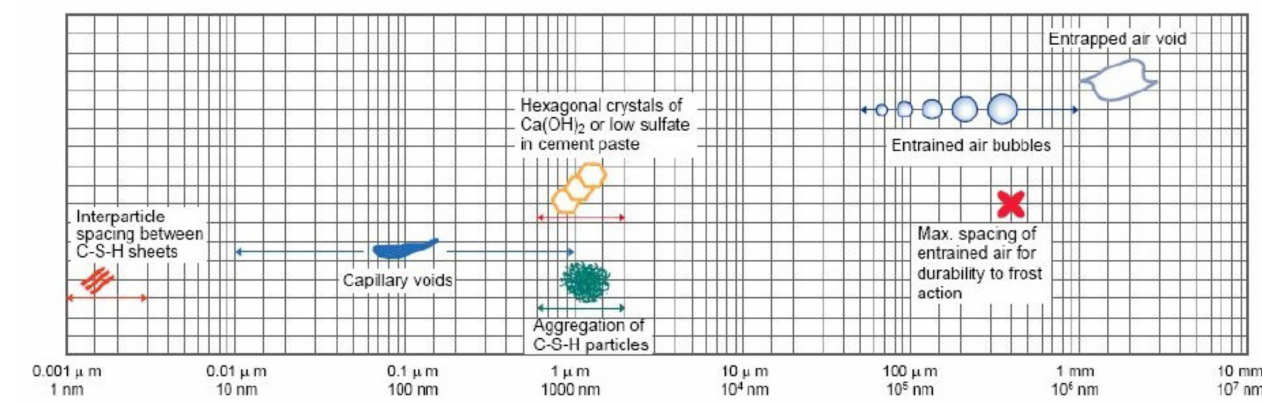
Figure 12. Dimensional range of solids and pores in a hydrated cement paste [30].